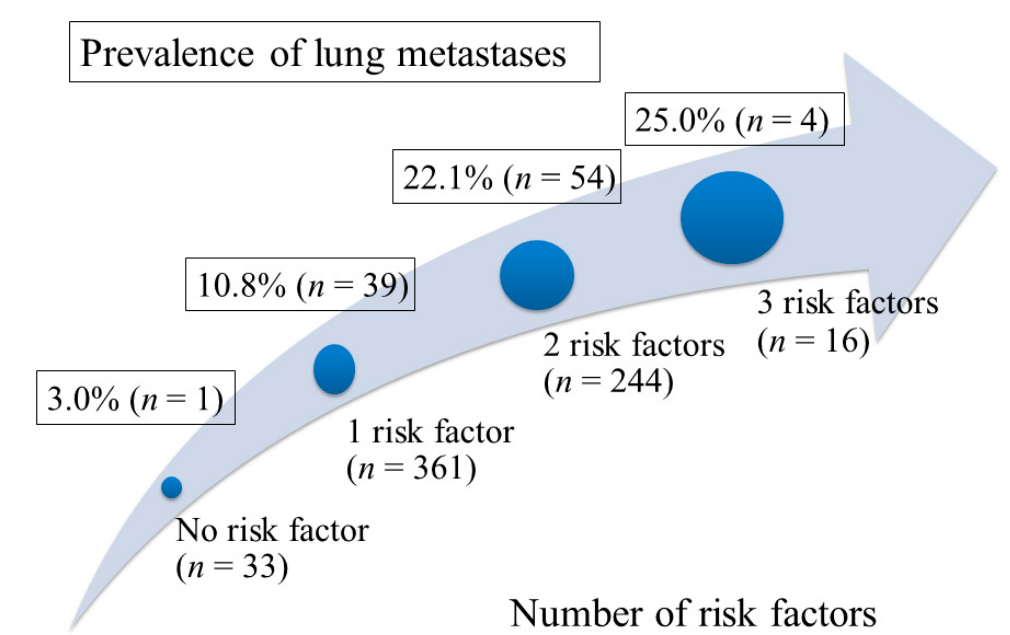
Figure 1. The prevalence of lung metastases according to the number of risk factors present in the patients. Risk factors for occurrence of lung metastases included female gender, poorly differentiated tumor grade, and primary tumor size ≥ 8 cm.